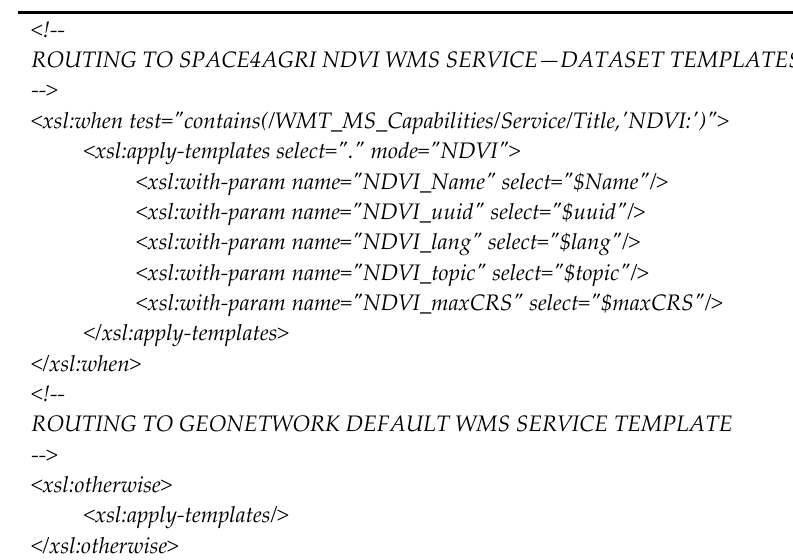
Table 2. XSL fragment for automatic metadata generation for NDVI GD.